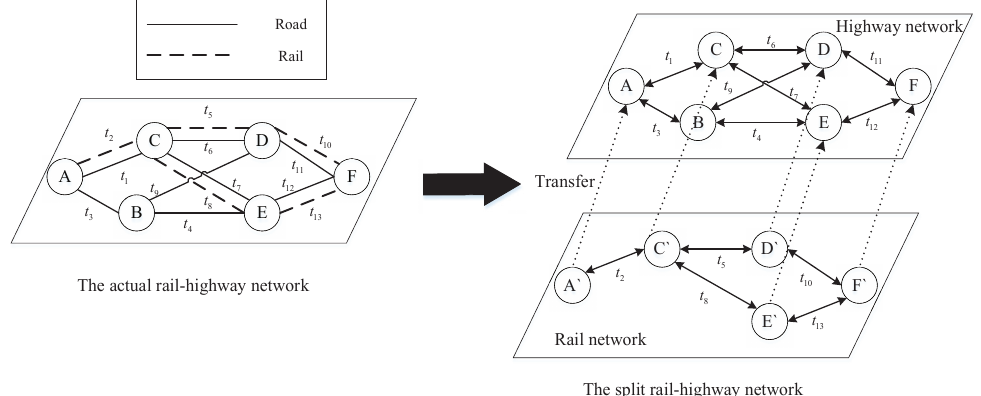
Figure 2. Network splitting in a multimodal traffic network, considering a rail-highway network as an